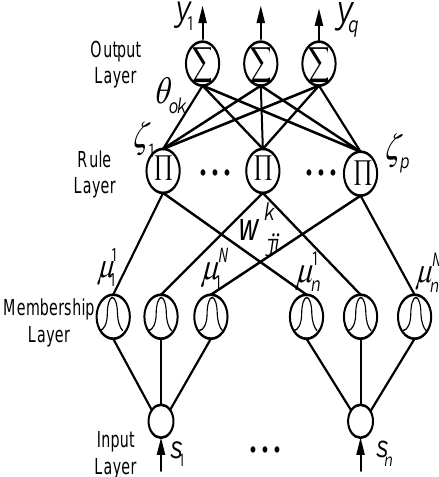
Figure 2. The structure of the neuro-fuzzy